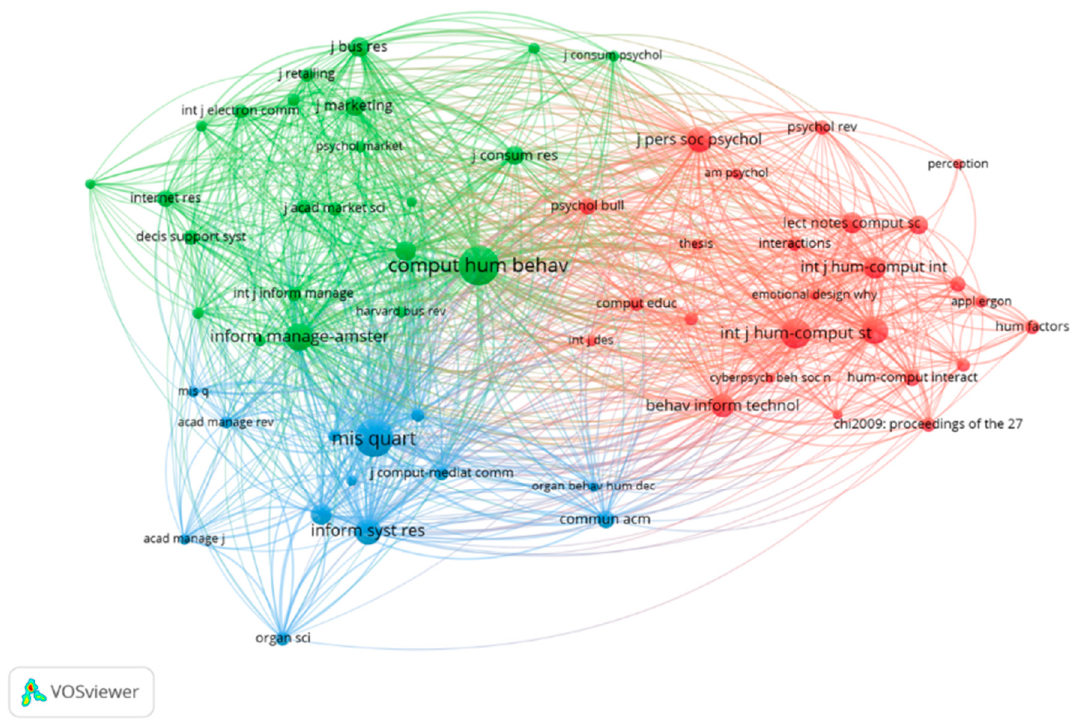
Figure 2. Sources co-citation map. Source: Own elaboration based on VOSViewer.